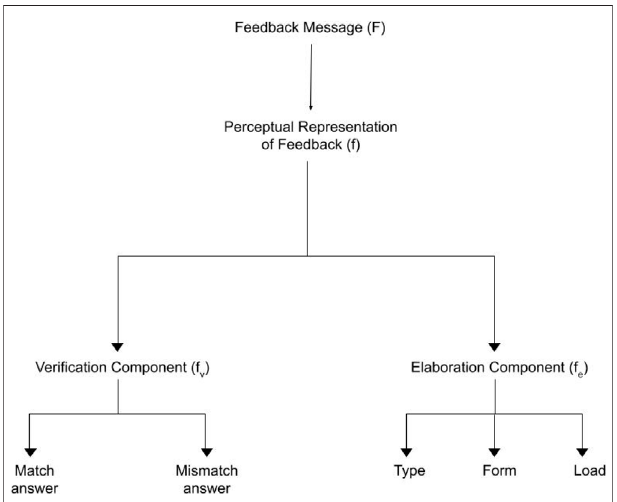
FIGURE 2 | Kulhavy and Stock (1989) feedback components.